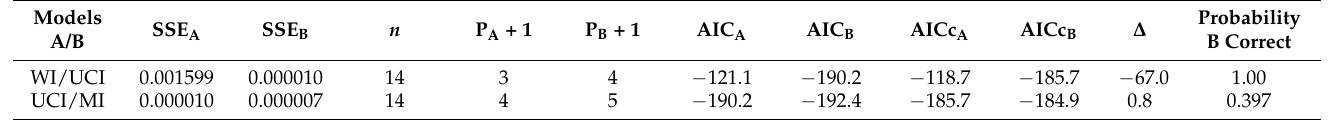
Table 4. Discrimination of the UCI model using AIC methodology with initial velocities data (MME). Models A/B